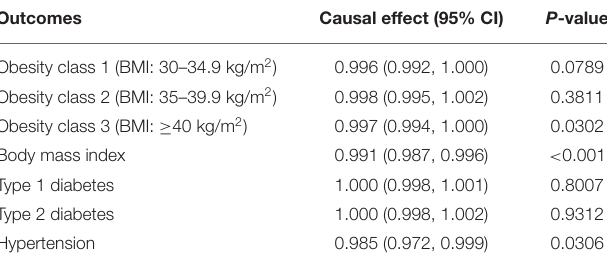
TABLE 3 | Causal effects between genetic predisposition toward circulating plasma vitamin C and